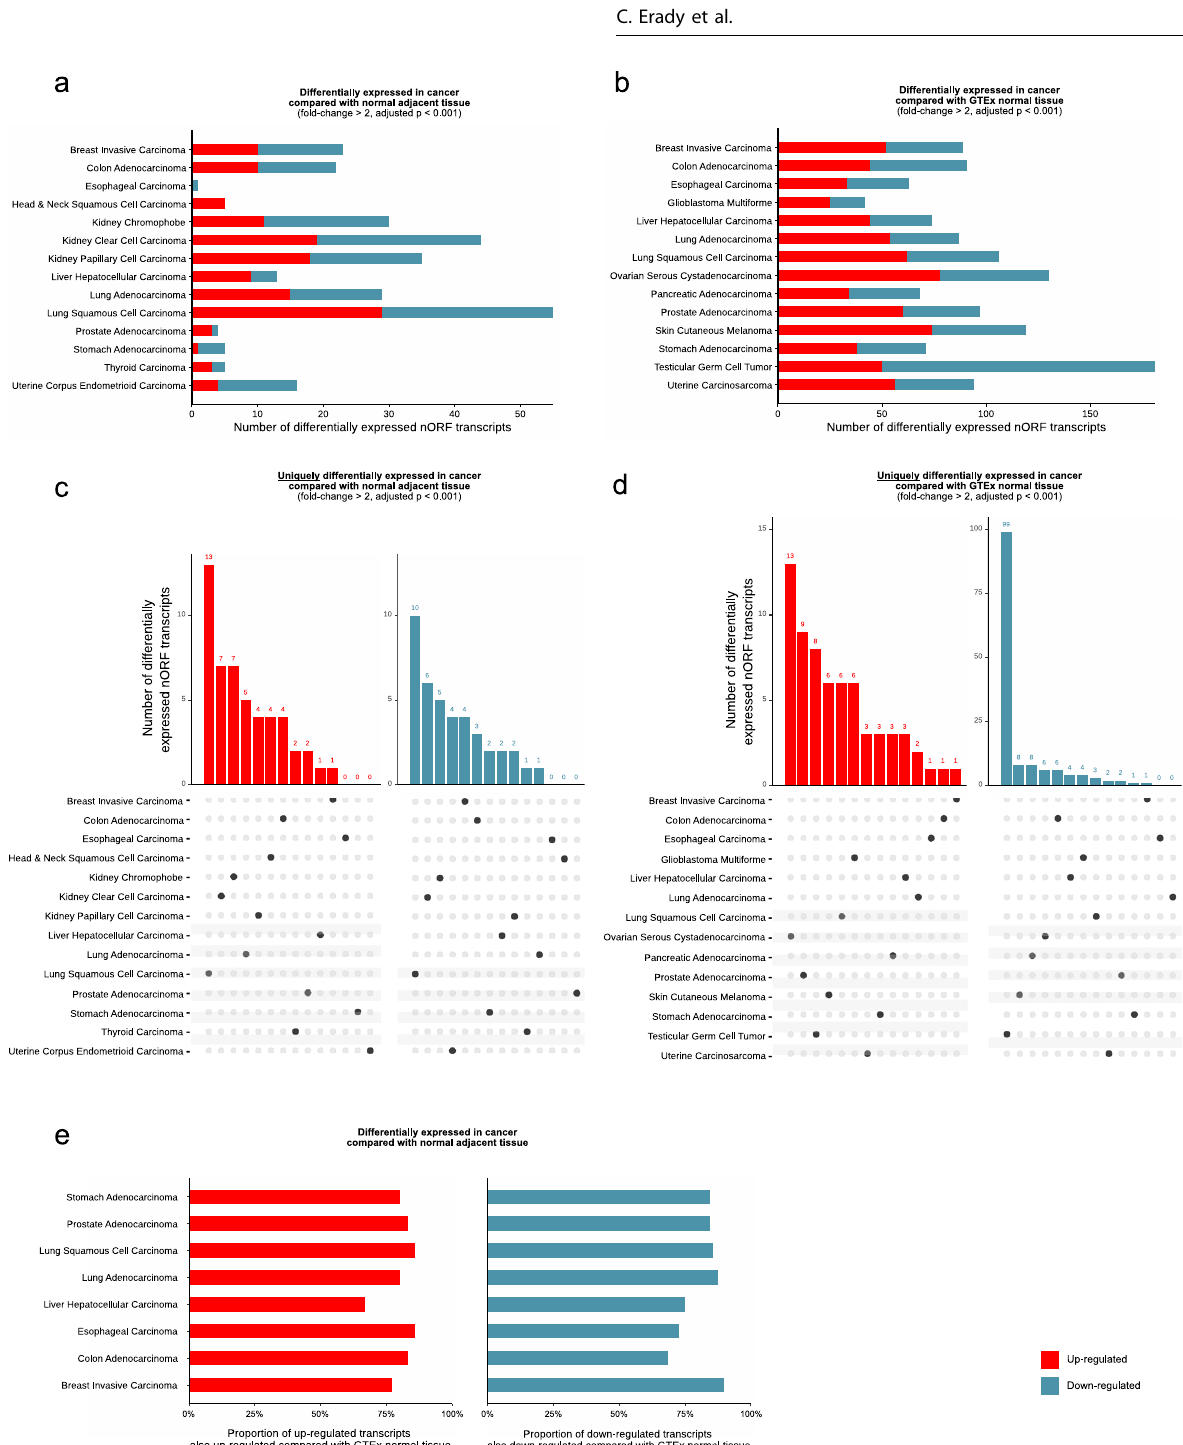
Fig. 2 Differentially expressed nORF transcripts in cancer. a Total number of differentially expressed nORF transcripts by cancer type compared with NAT. b Total number of differentially expressed nORF transcripts by cancer type compared with GTEx. c nORF transcripts uniquely up-regulated or down-regulated in a single cancer type compared with NAT. d nORF transcripts uniquely up-regulated or down- regulated in a single cancer type compared with GTEx normal tissue. e Reproducibility of differential expression results using normal adjacent tissue and GTEx normal tissue. nORF transcripts identi fi ed as differentially expressed when comparing cancer tissue with normal adjacent tissue, showing the proportion of nORF transcripts also differentially expressed when comparing cancer tissue with GTEx tissue (left: up- regulated nORF transcripts, right: down-regulated nORF